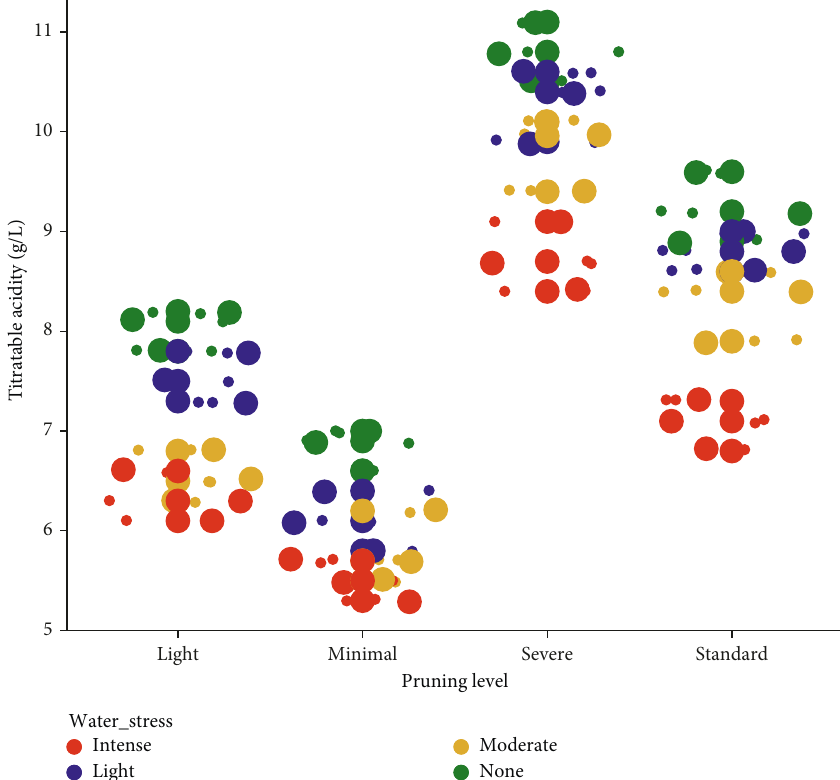
Figure 9: Response of berry juice titratable acidity to different pruning